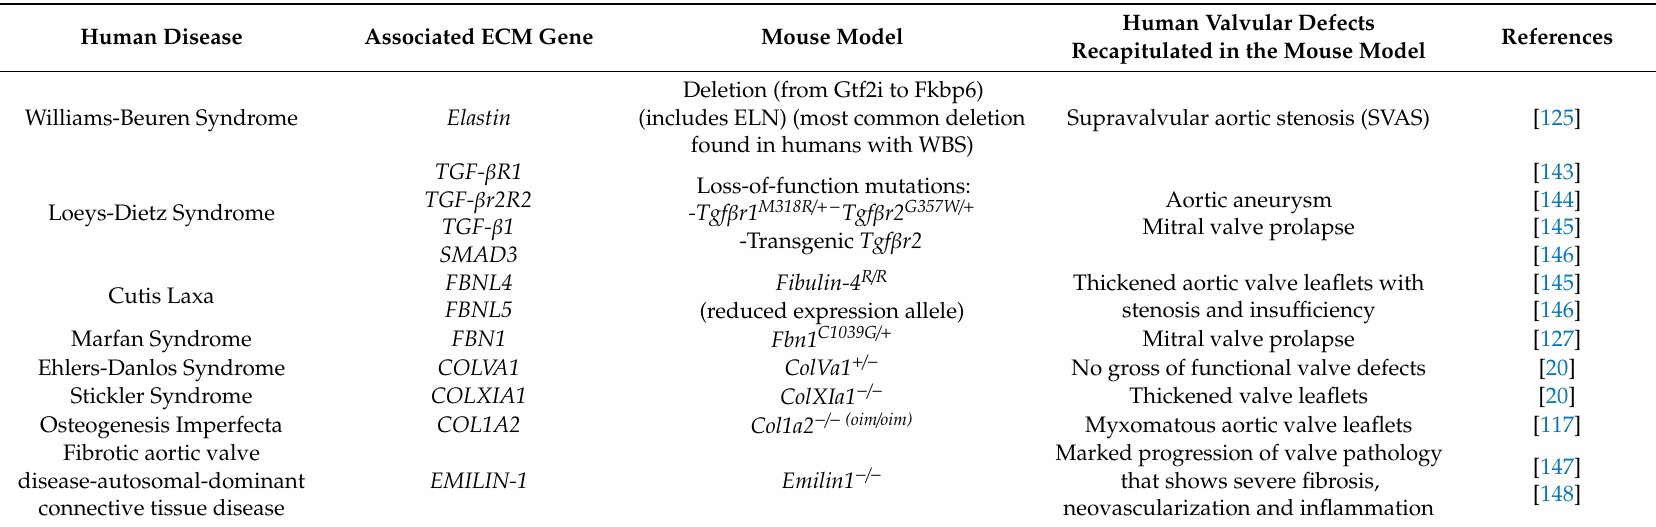
Table 1. Mouse models of human connective tissue disorders with valvular